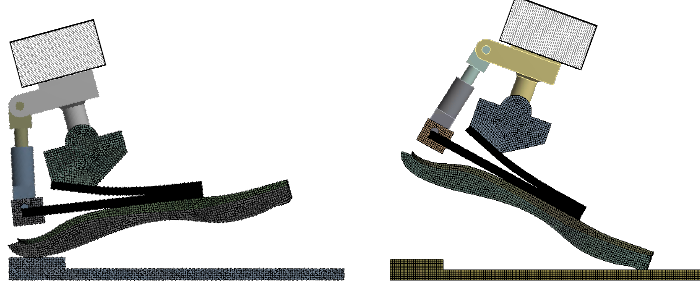
Figure 13. The 3D FE models for plantarflexion and dorsiflexion tests.